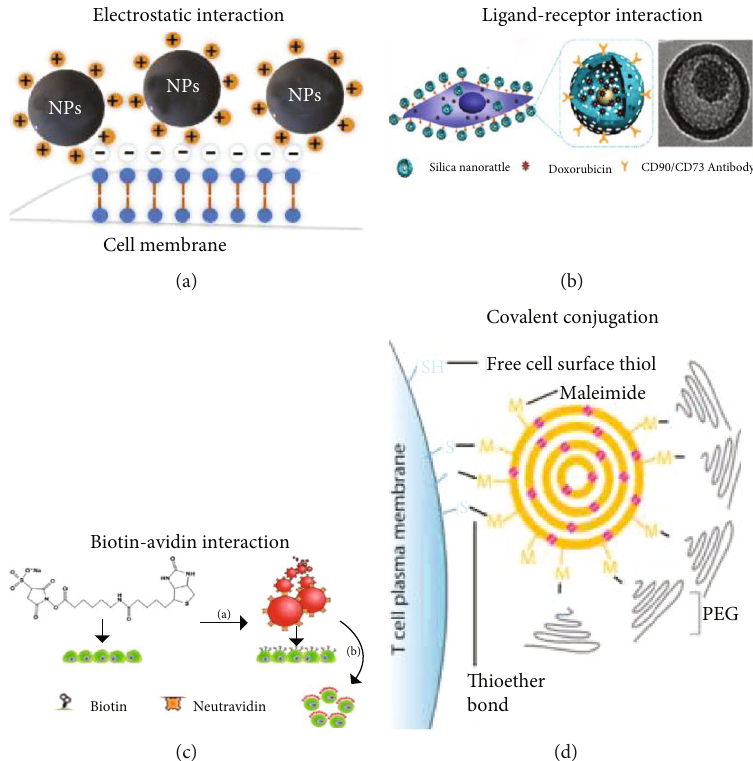
Figure 2: (a) Scheme of NPs conjugated with cell membranes via electrostatic interaction. (b) Dox was bound on the MSC membranes via the CD90/CD73 antibody-ligand interaction. Reproduced with permission [52]. Copyright 2011. American Chemical Society. (c) FluoSpheres (red) modi fi ed by NeutrAvidin (orange) to bind to biotinylated MSC membranes. Reproduced with permission [58]. Copyright 2010. American Chemical Society. (d) SN-38 NPs were anchored on T cells via a thiol group expressed on the cell membrane. Reproduced with permission [12]. Copyright 2015. American Association for the Advancement of